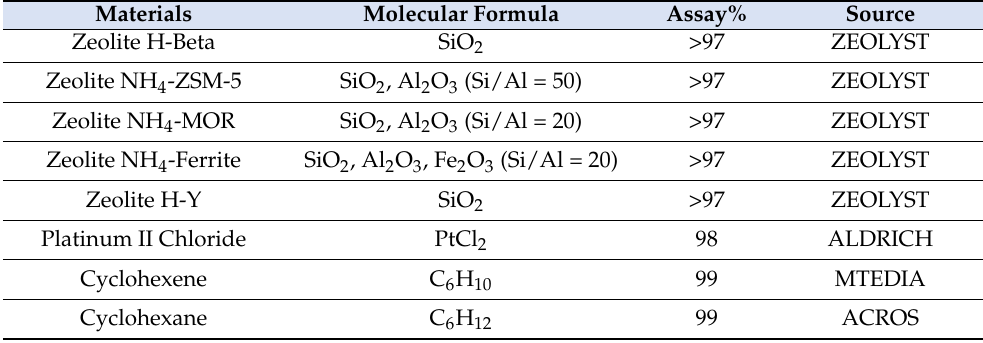
Table 1. A list of materials which were used in this